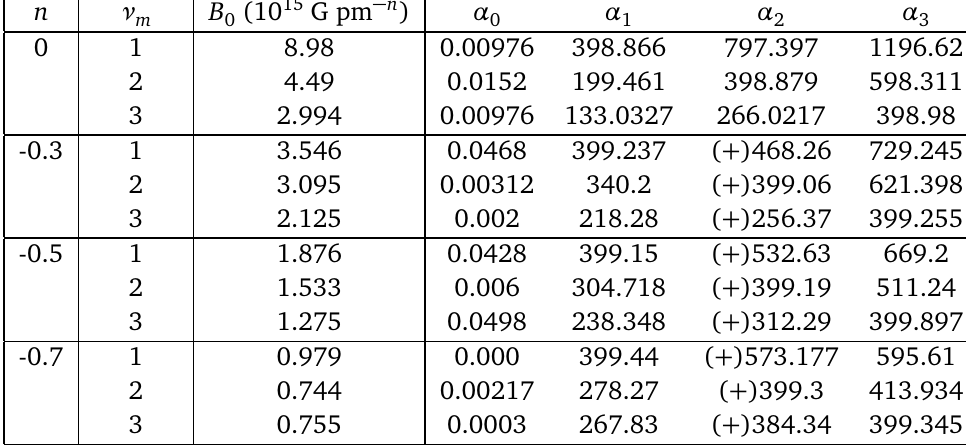
Table 3: The variation of B for different n for one-level, two-level and three-level 0 systems at ε = 20. For n = 0, all the levels are doubly degenerate. For n (cid:54) = 0 all eigenvalues are different independent of energy levels and splits + σ · B and − σ . B